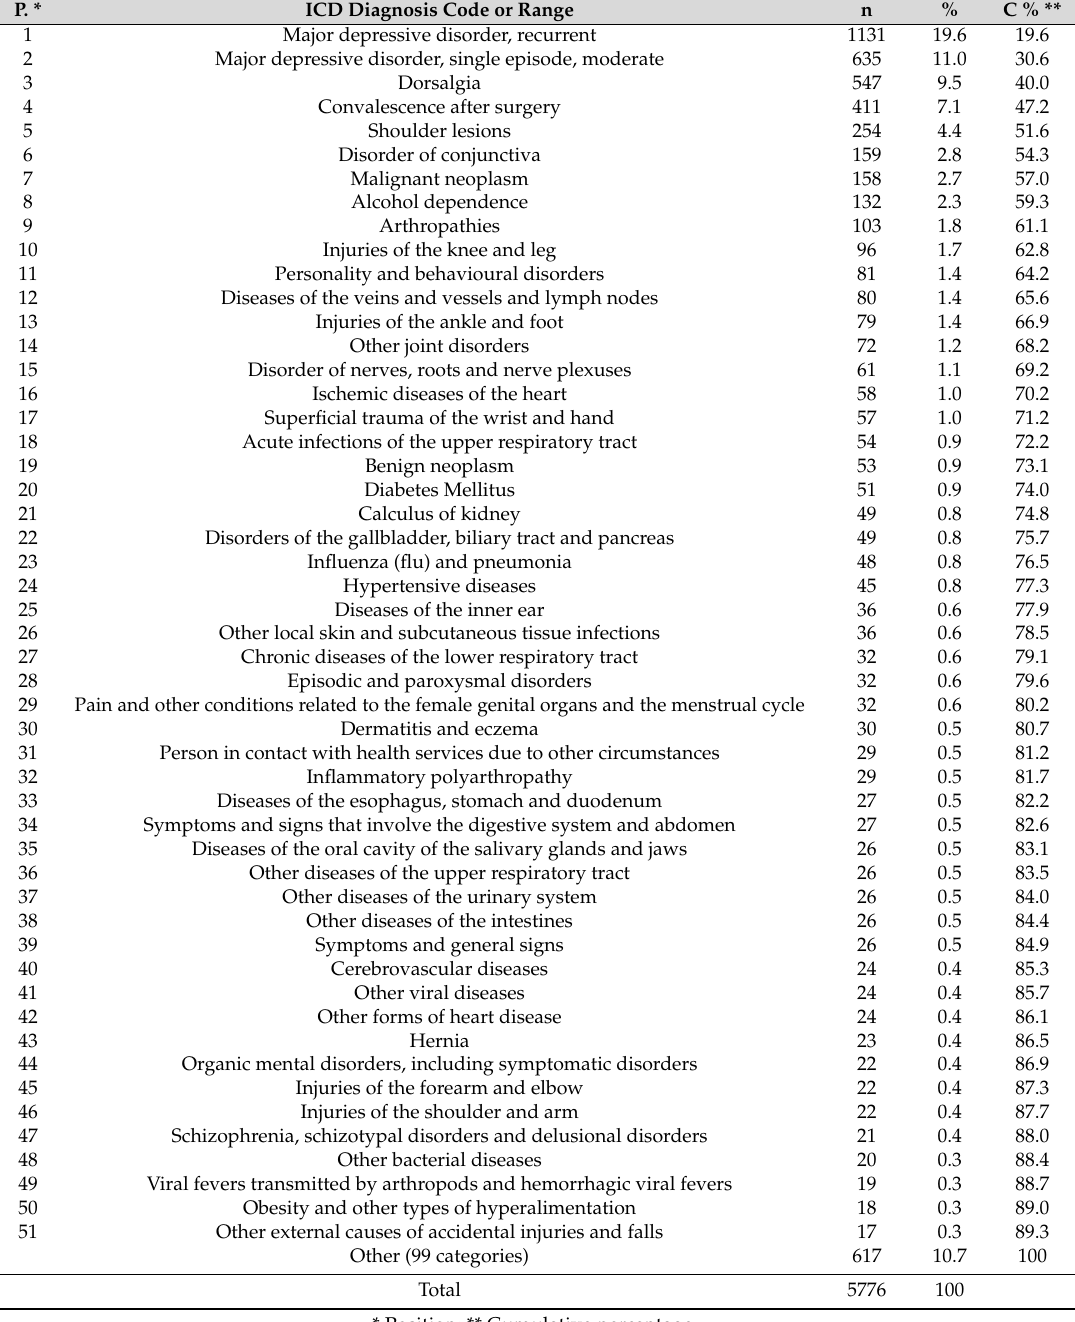
Table 3. Main causes of 5776 sick leaves (ICD diagnosis code or